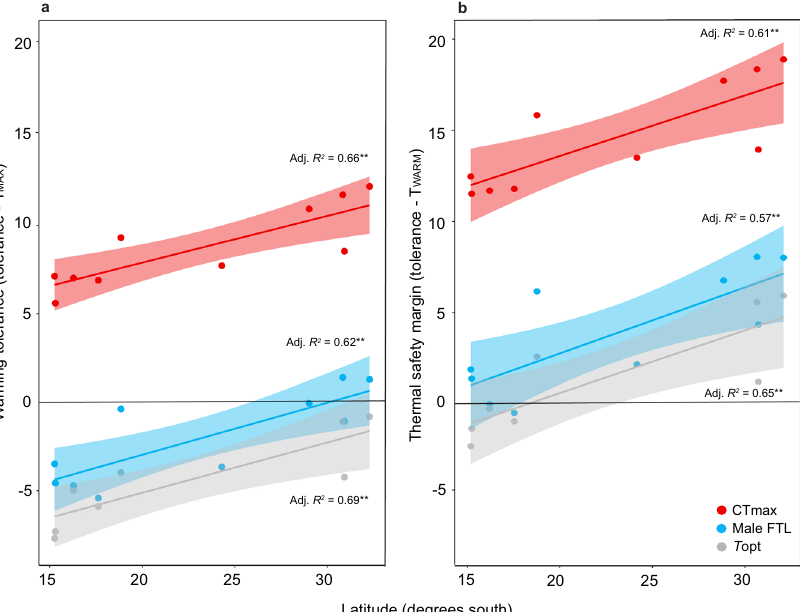
Fig. 3 Thermal safety margins and warming tolerances across latitude for ten Drosophila species using different estimates of thermal tolerance. a Warming tolerance (tolerance minus maximum habitat temperature (T MAX )) and b thermal safety margins (tolerance minus average habitat temperature during summer months (T WARM ) calculated using critical thermal maxima (knockdown CTmax, red), male upper fertility thermal limits (male FTL 50 , blue) and optimum thermal temperature ( T opt, grey, note only eight species)) were lower in species from low latitudes. Warming tolerance ( a ) and thermal safety margins ( b ) using CTmax were higher than thermal safety margins using male FTLs ( b ). Each point represents warming tolerance/thermal safety margins for single species, the solid lines represent the fi tted linear models and the shaded areas are the 95% con fi dence interval of these models. Source data are provided in the Source Data fi